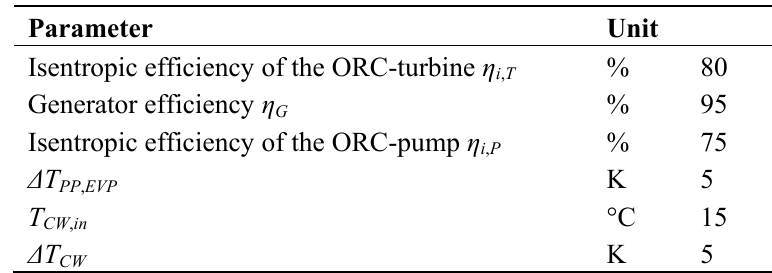
Table 1. Boundary conditions for the ORC power plant.